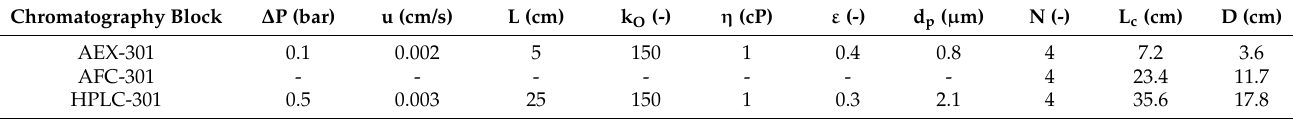
Table 7. Kozeny-Blake equation parameters and chromatographies’ design specifications [20,26,27,51,53,54].